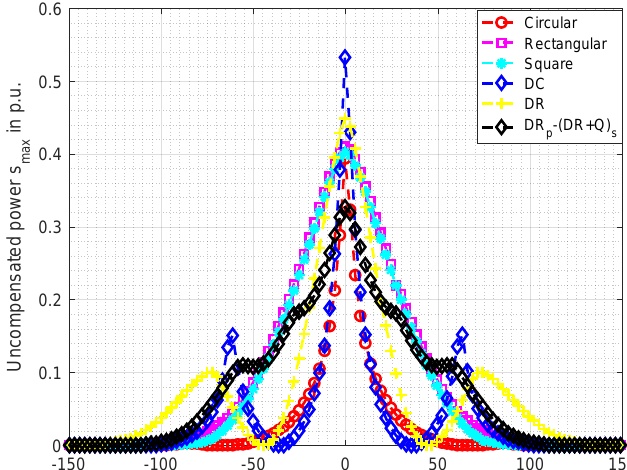
Figure 12. Uncompensated power analyzed on the basis of a unit current flowing through various shapes of a single turn and equal area as indicated in Table 2. The misalignment is considered along the x-direction.